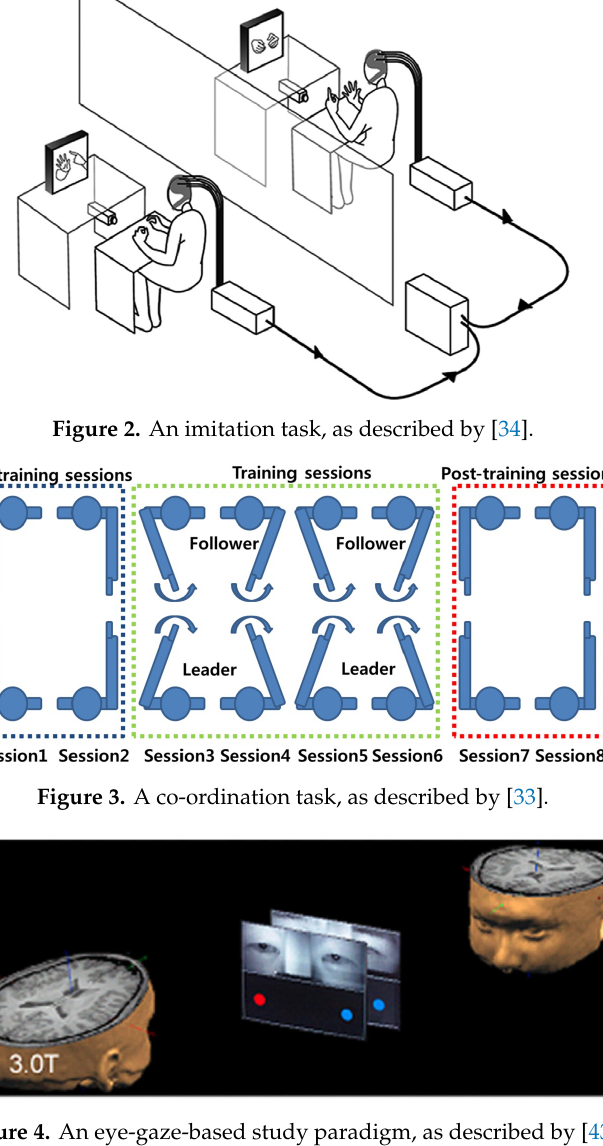
Figure 4. An eye-gaze-based study paradigm, as described by